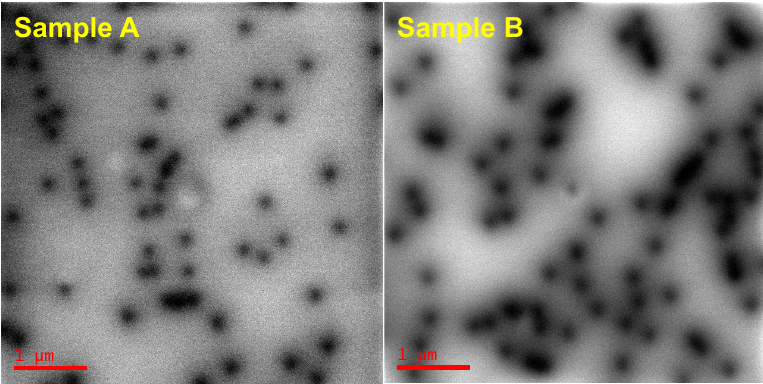
Figure 2. The CL images of samples A and B.